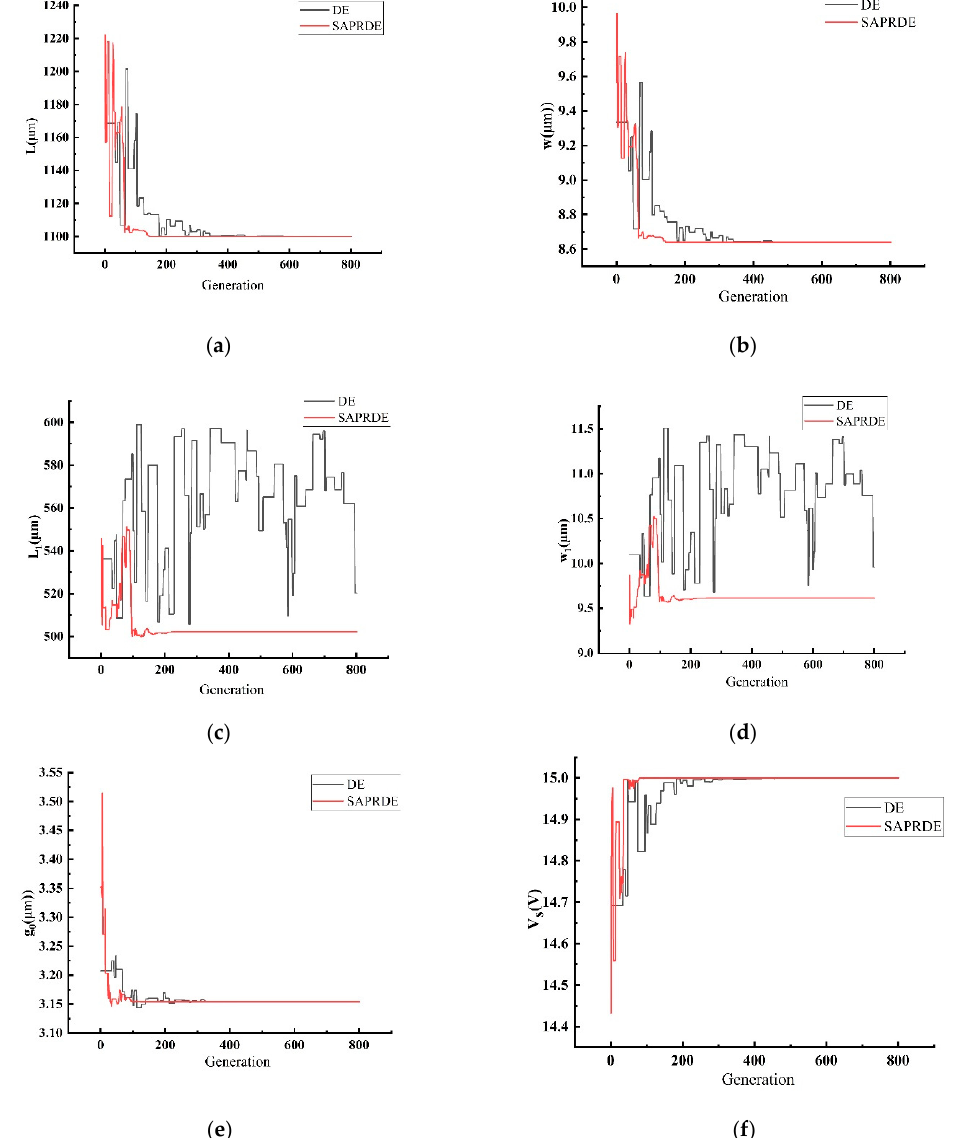
Figure 4. The optimization process of each parameter before and after algorithm improvement. ( a ) Length of the resonant beam L ; ( b ) width of the resonant beam L ; ( d ) width of support beam 1